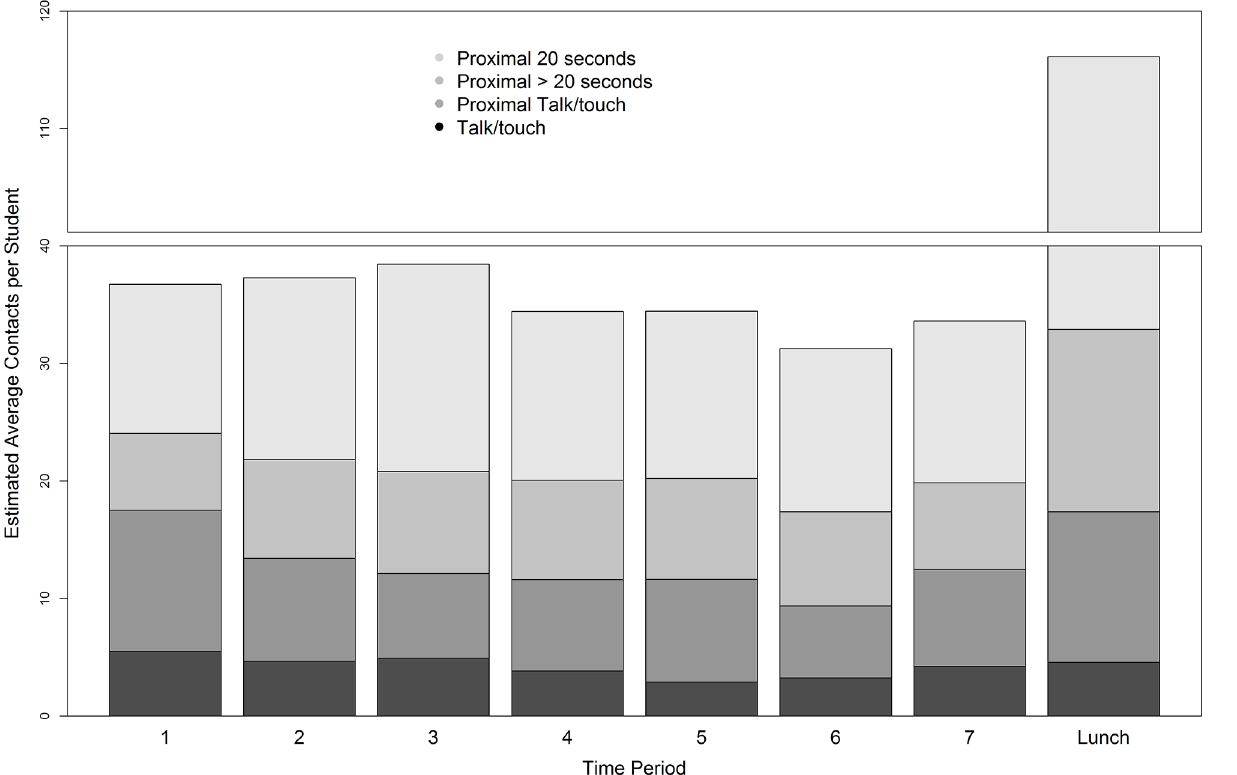
Fig 6. Estimated average T, PT, and P (separated for (cid:7) and > 20 seconds) contacts per student during class periods and